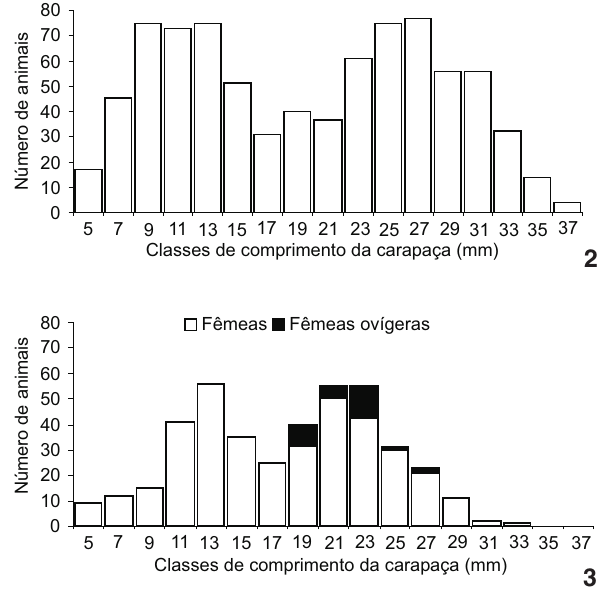
Figuras 2-3. Distribuição de freqüência de tamanho de machos (2) e fêmeas (3) de A. schmitti nas classes de comprimento da carapaça